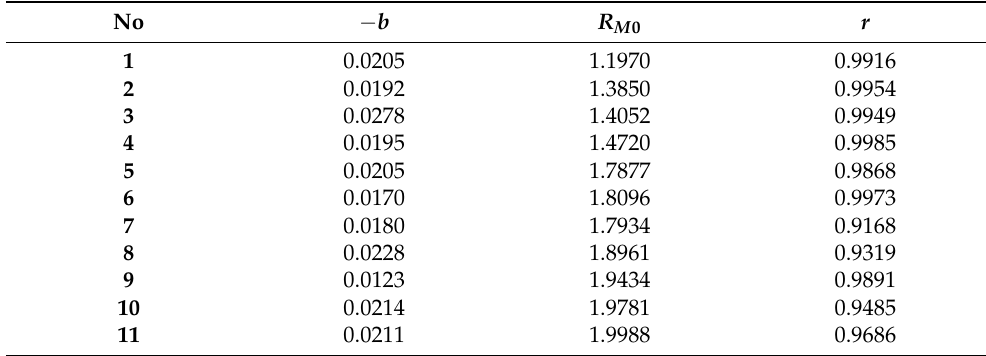
Table 2. The R M 0 values and b (slope) and r (correlation coefficient) of the equation R M = R M 0 + b C for compounds 1 – 11 .